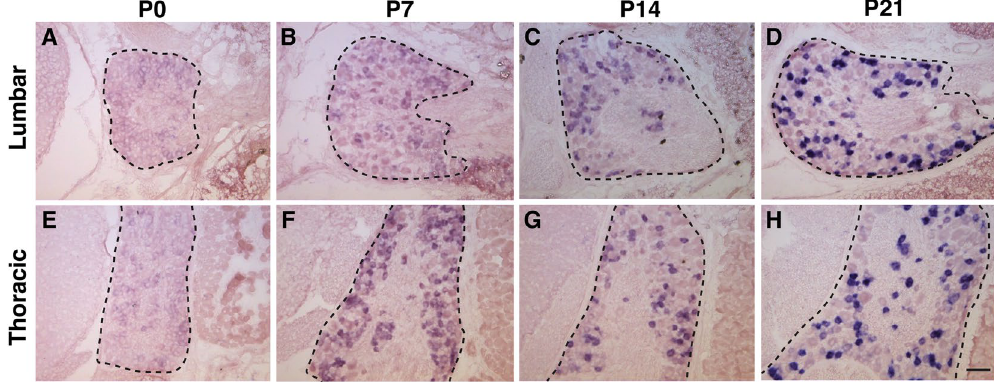
Figure 1. Expression of TrpC 3 in thoracic and lumbar level DRG neurons. ( A – D ) AP colorimetric in situ hybridization for TrpC3 in P0–P21 WT mouse DRG thoracic sections. ( E – H ) AP colorimetric in situ hybridization for TrpC3 in P0–P21 WT mouse DRG lumbar sections. In DRGs from both levels, TrpC3 expression is low at birth and reaches a high level at P21. DRG is outlined by the dashed black line. N = 3 mice for each age. Scale bar = 50 μ